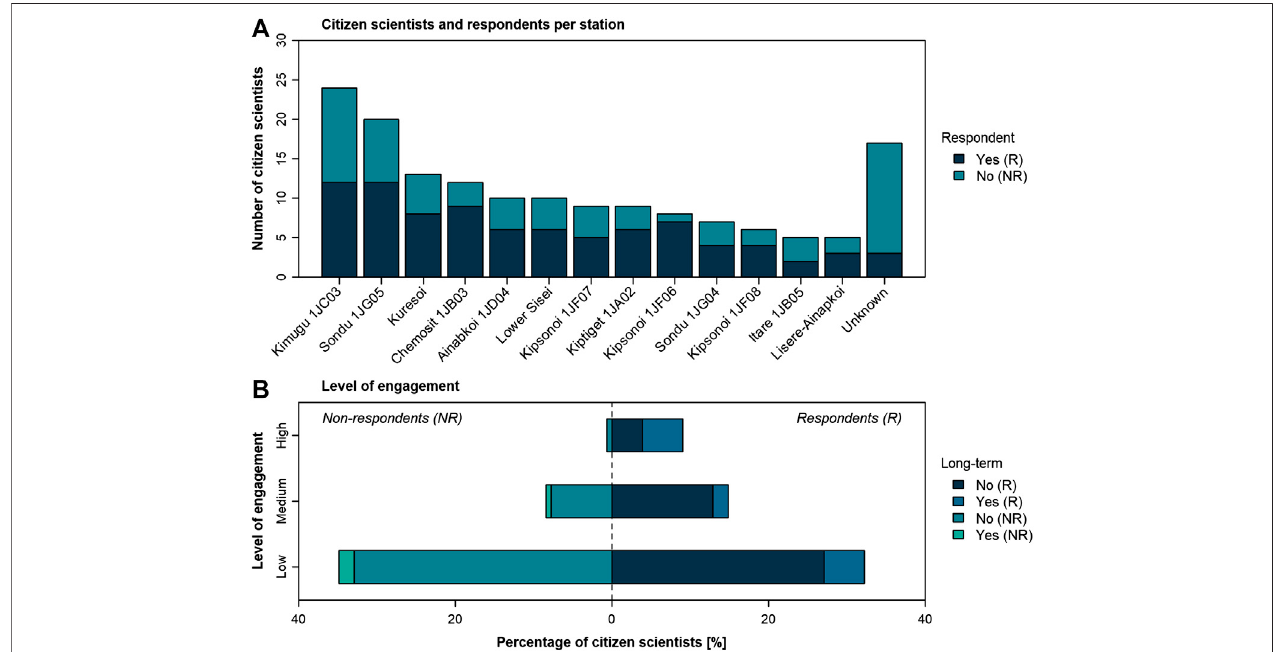
FIGURE 2 | Number of citizen scientists ( n (cid:2) 155), classi fi ed as survey respondent (R) or non-respondent (NR) of the survey, (A) per site and (B) by level of engagement in the crowdsourced water monitoring project in the Sondu-Miriu basin, Kenya between April 2016 and June 2017. Overall engagement was assessed by totalnumberofvalidmeasurementsuntilJune2017(Low (cid:2) 0 – 1,Medium (cid:2) 2 – 9,High (cid:2) 10ormore).Long-termengagementwasassessed basedonthecontributionof additional measurements after June